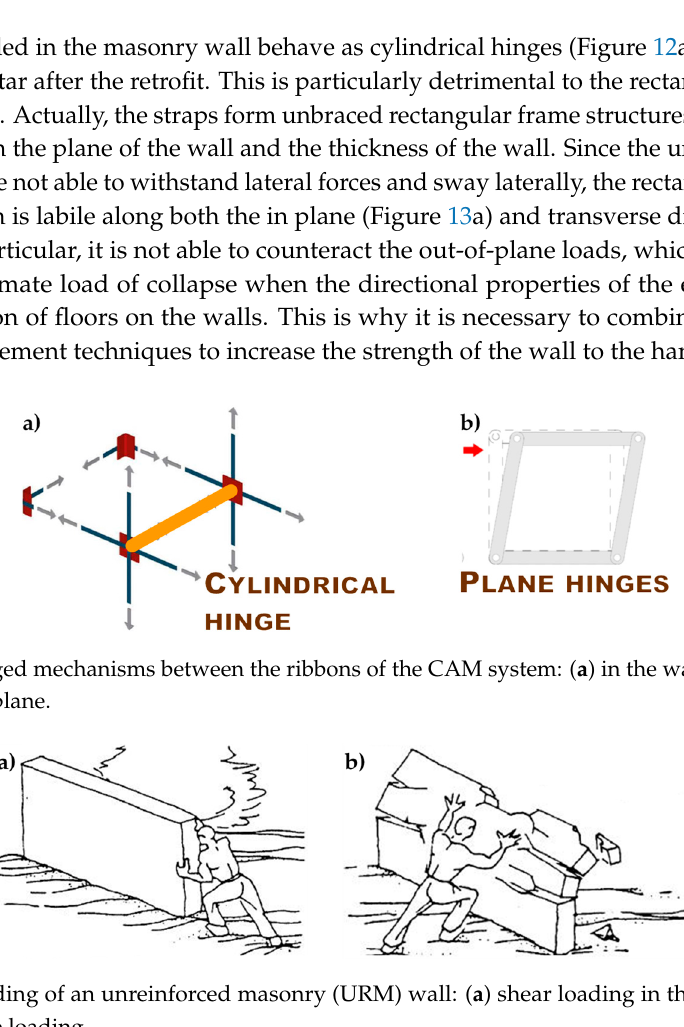
Figure 14. Optimized arrangement of straps to counteract the in-plane shear loads.